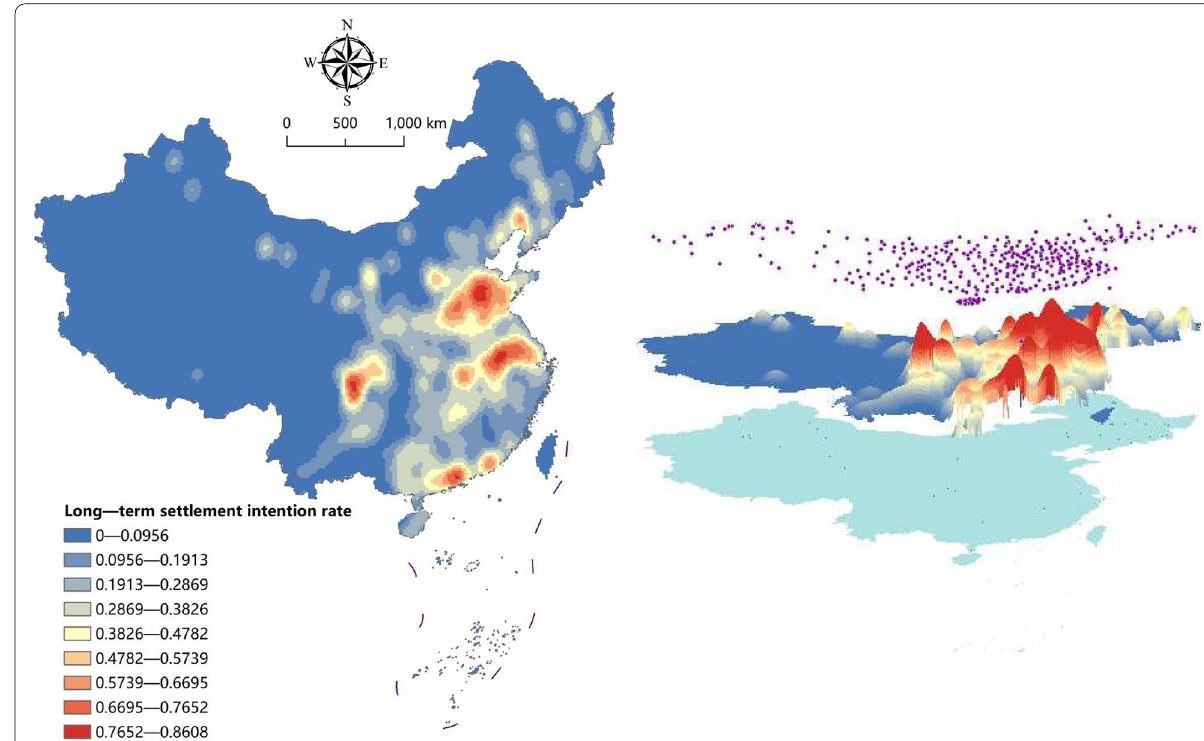
Fig. 5 Kernel density of settlement intention. Data source: China Migrants Dynamic Survey (CMDS;